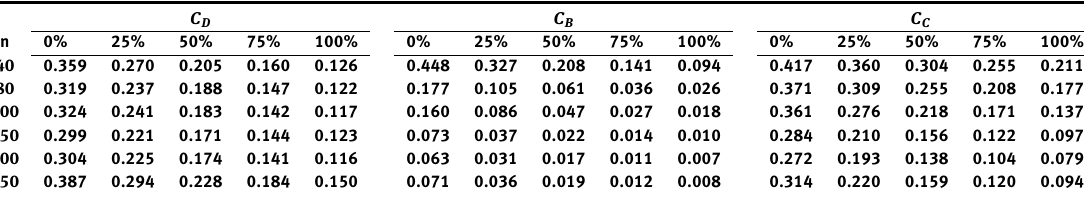
Table 1. Absolute values of degree network centrality ( C D ), betweenness network centrality ( C B ) and closeness network centrality ( C ) for the original simulated networks and extended networks with 0% , 25%,50%,75% and 100% of ancillary C